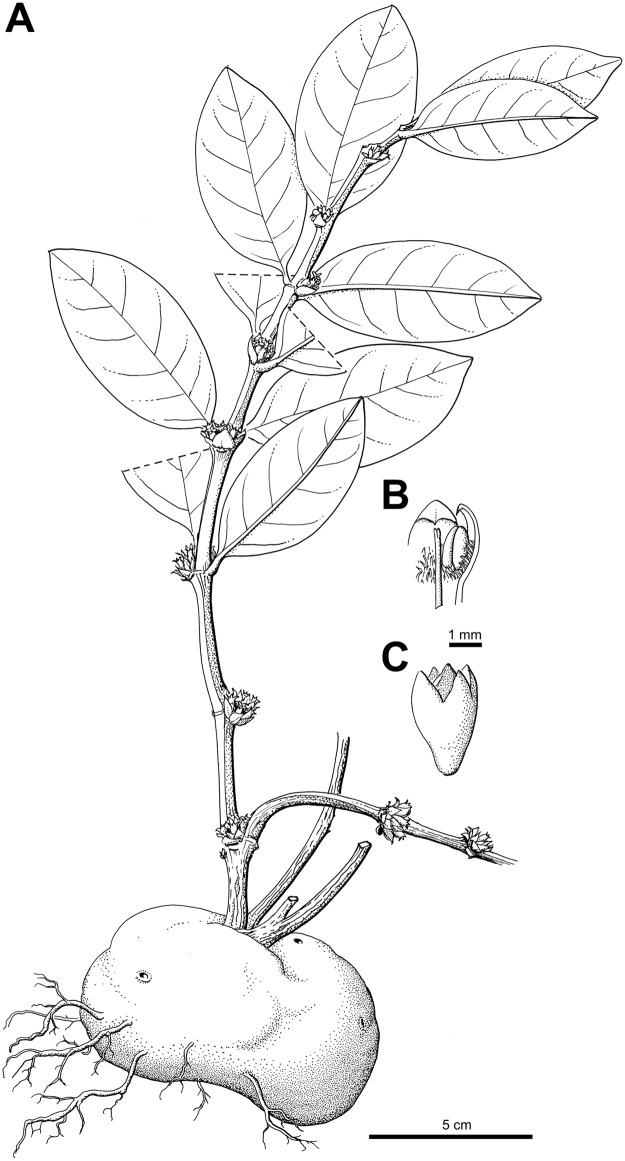
Squamellaria vanuatuensis Jebb & C.R.Huxley, spec. nov.(A). Habit showing the domatium; (B). Inner view of flower throat; (C). Hypanthium and calyx. Scale bar 5 cm for A; 5 mm for B and C. Drawn by Rosemary Wise from herbarium specimens: A = L. Bernardi 13238 (G, barcode G-62446); B, C = Green 1274 (K, barcode K000772005).